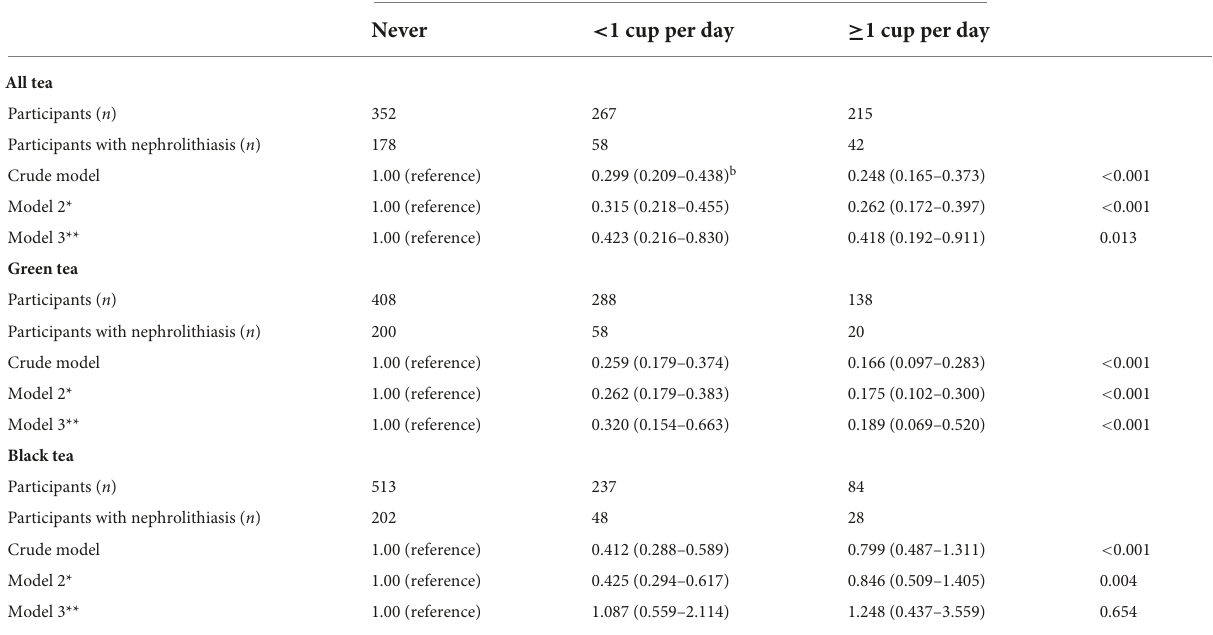
TABLE 2 Adjusted association between tea intake and